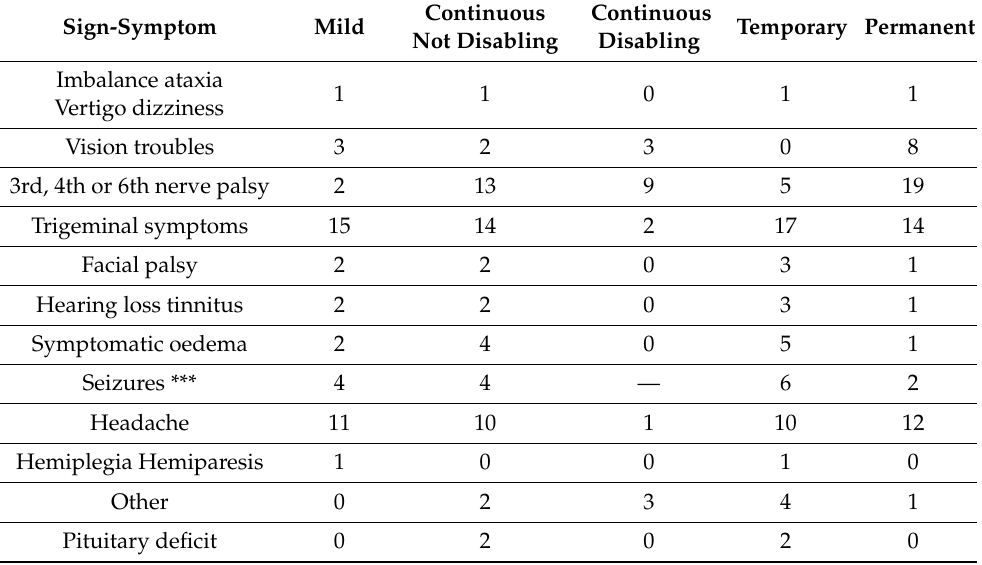
Table 7. Complications after SRS in 113 patients *, **.